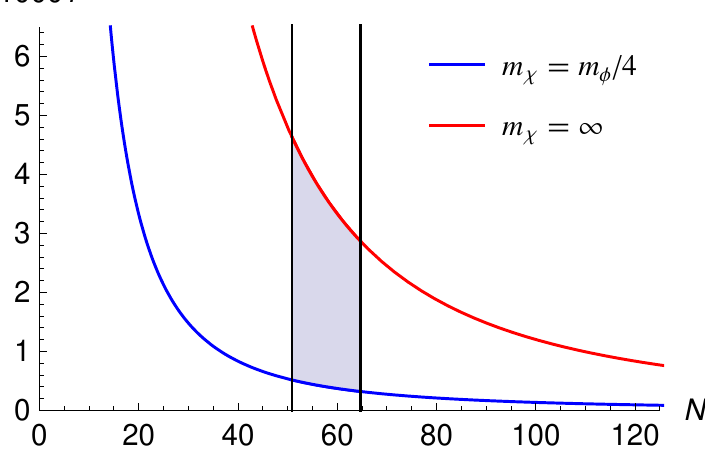
Figure 1 . Allowed values of the tensor-to-scalar ratio r